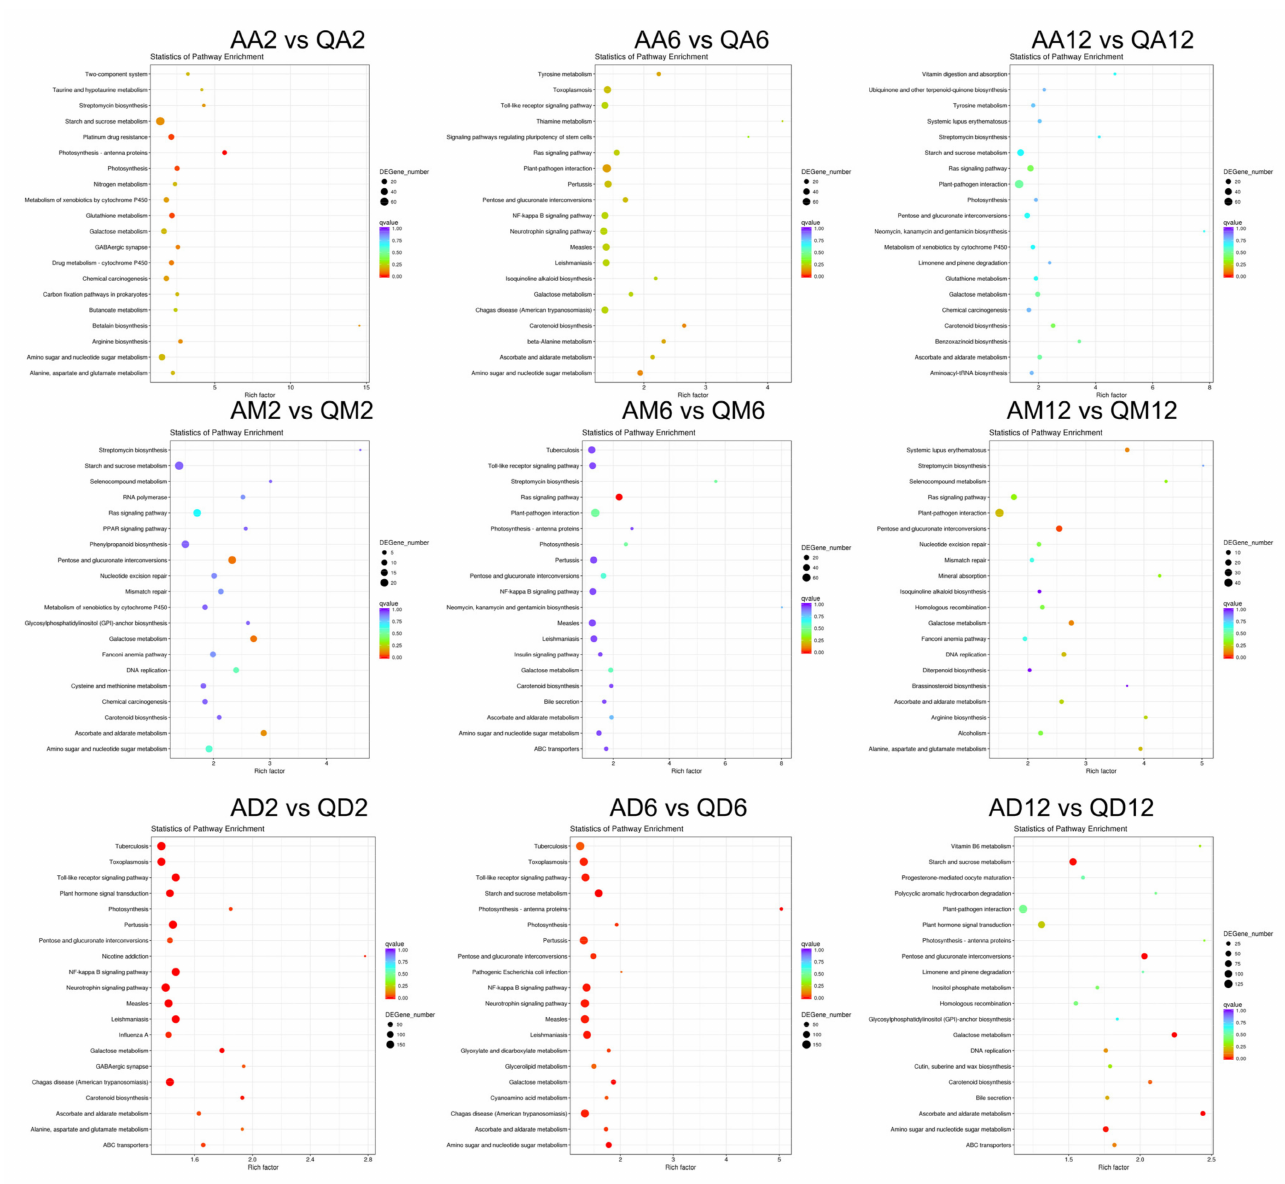
Figure 6. Functional enrichment of DEGs in KEGG database. Histogram of the most significantly enriched KEGG pathway of potato DEGs under treatment. The ordinate is the enriched KEGG pathway; the abscissa is the number of DEGs on the column. Different colors distinguish different significances. Red represents extremely prominent and blue represents generally significant. The diameter of the circle represents the number of enriched